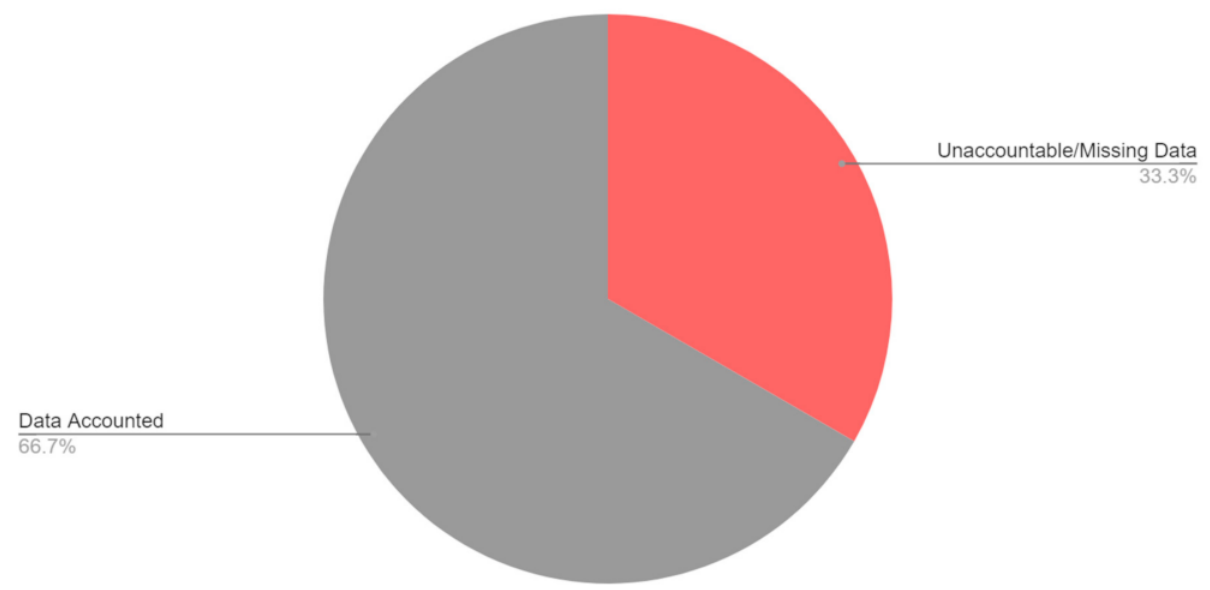
Figure 12. Reporting and accountability of data in